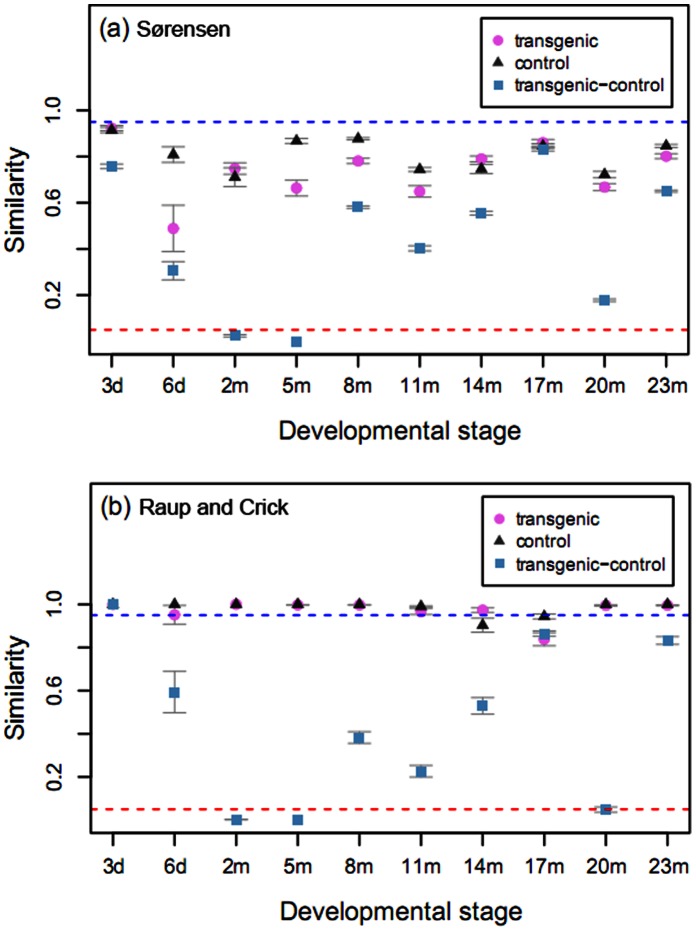
Comparison of similarities and differences for gut microbiota composition between transgenic fish and wild-type controls across different developmental stages.(a) Comparison of the average Sørensen index obtained from DGGE patterns of 16S rRNA genes between transgenic fish and wild-type controls or within each group of transgenic fish and wild-type controls. (b) Comparison of Raup and Crick similarity index (S
RC) obtained from DGGE patterns of 16S rRNA genes between transgenic fish and wild-type controls or within each group of transgenic fish and wild-type controls. Dashed lines indicate significant cutoff for difference (low line) and similarity (upper line). Error bars represent the standard error of the mean.